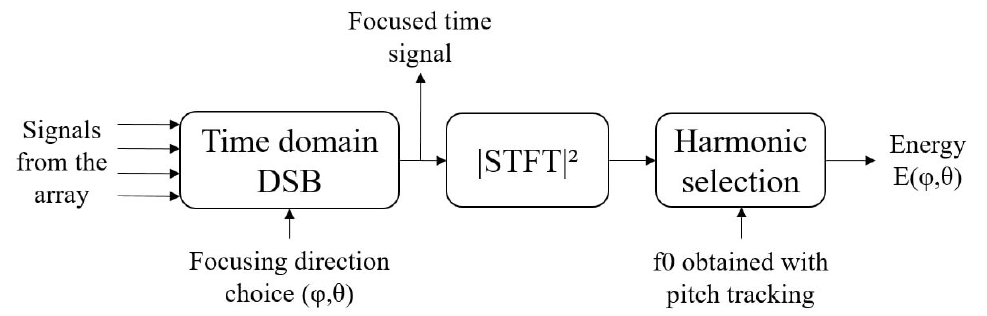
Figure 2. Synopsis of the proposed